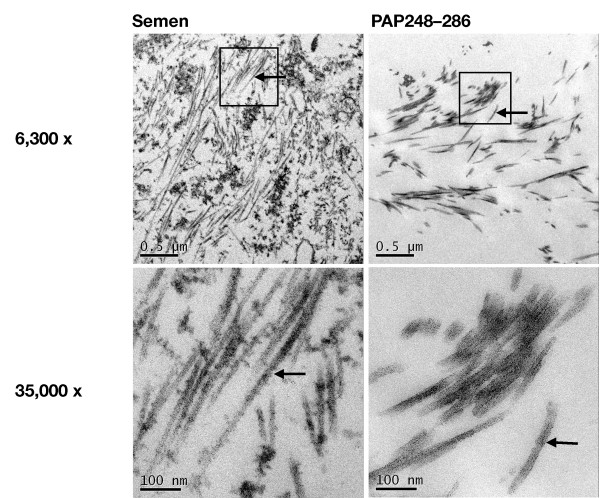
Transmission electron microscopy analysis of semen and synthetic SEVI in a closed system. A fresh semen sample and a solution of chemically synthesized SEVI (PAP-fragment PAP248-286) were analyzed as described in the methods section. The bottom images depict a detail (magnification: 35,000 ×) of the above electron micrographs (magnification: 6,300 ×). The semen sample shows a high density of fibrils with lengths ranging from 300 nm to about 3 μm, that exhibit a clear resemblance to the fibrils formed from chemically synthesized SEVI (PAP-fragment PAP248-286). The synthetic SEVI fibrils frequently run out of pane due to the embedding angle. Arrows indicate typical fibril structures.